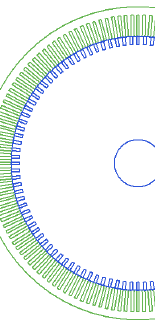
Figure 8. Ansys RMxprt model of medium voltage machine.